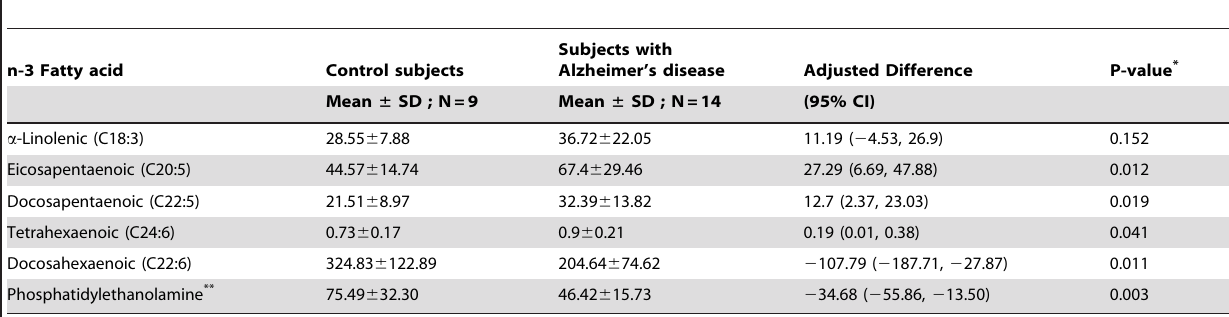
Table 3. Levels of free n-3 fatty acids (nmol/g) and docosahexanoate-containing phosphatidylethanolamine (nmol/g) in liver of control subjects and subjects with Alzheimer’s disease.